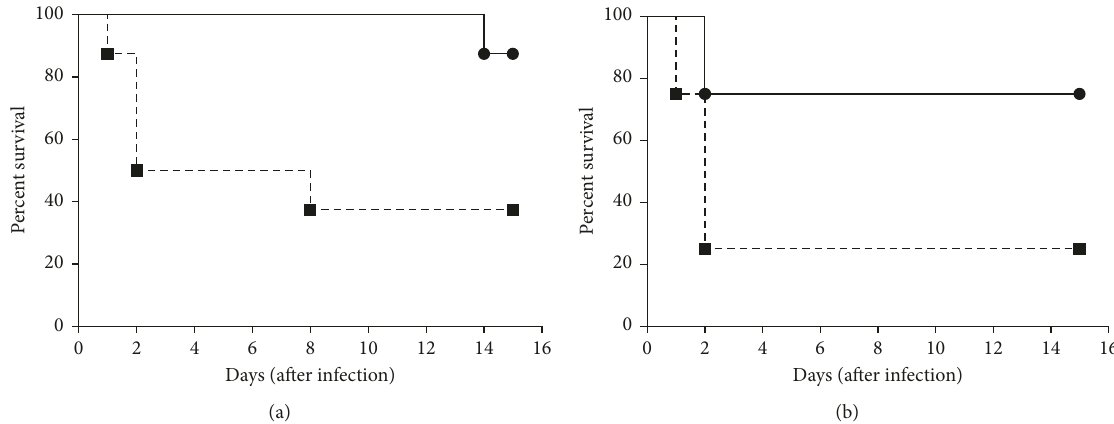
Figure 4: Protection of mice against group A streptococcus challenge after immunization with the vaccine. (a) Survival curves of mice challenged with M1 GAS. Immunized group mice ( n 8, black circles) and control group mice ( n (cid:30) injected of 1.0 10 8 CFU M1 GAS 21 days after the last immunization. Immunized group mice had a higher survival rate than non- × immunized group mice (87.5% versus 37.5%, P 0 . 0294). (b) Survival curves of mice challenged with M12 GAS. Immunized group mice (cid:30) ( n 8, black circles) and control group mice ( n 8, black squares) were intraperitoneally injected of 1.0 (cid:30) (cid:30) the last immunization. Immunized group mice had a higher survival rate than nonimmunized group mice (75% versus 25%, P Statistical significance was determined by the log-rank